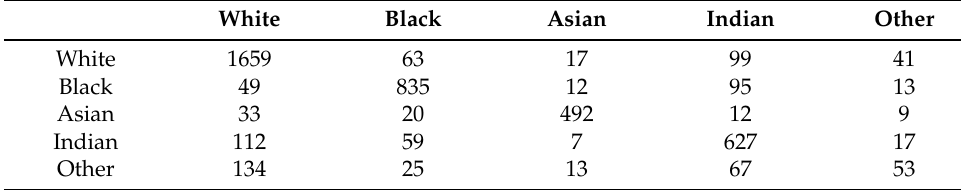
Table 10. Confusion matrix for the UTKFace filtered testing without plotted